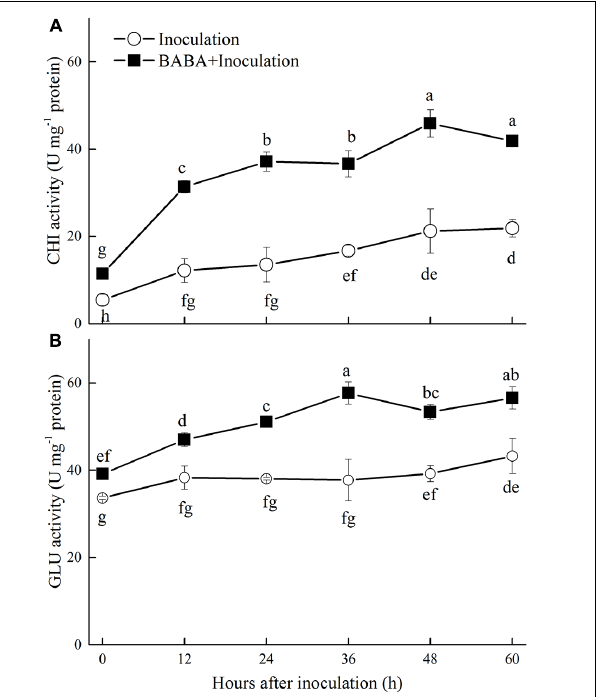
FIGURE 2 | Changes in chitinase (CHI) (A) and β -1,3-glucanase (GLU) (B) activities in peach fruit inoculated with Rhizopus stolonifer (Inoculation) or pretreated with 50 mM BABA and then inoculated with R. stolonifer (BABA + Inoculation) during storage at 20 ◦ C. Data are expressed as the mean of triplicate samples. Vertical bars represent the standard errors of the means. Letters without the same letter above the bars indicate significant differences at P <